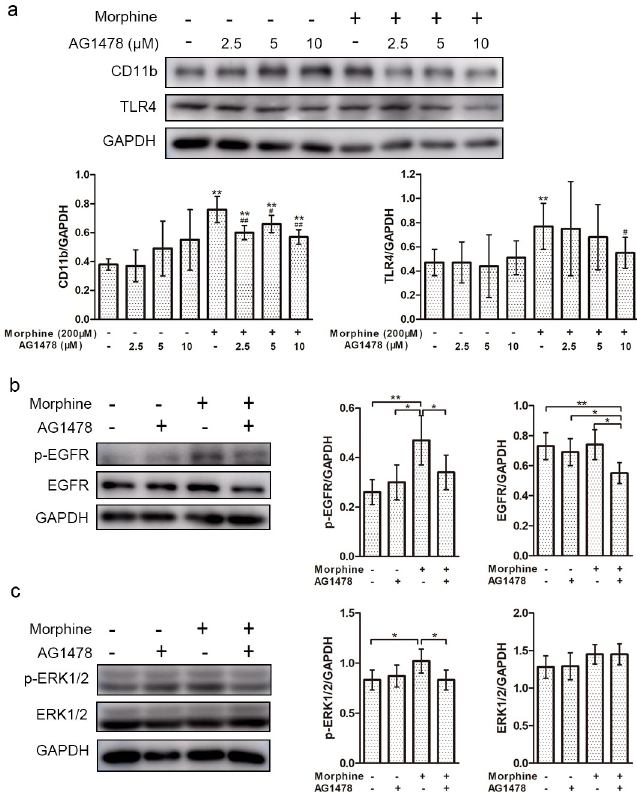
Fig 5. The effect of EGFR inhibition on morphine-induced protein expression. BV-2 cells were incubated with DMSO, AG1478 (2.5, 5, and 10 μ M), morphine (200 μ M), and AG1478 (2.5, 5, and 10 μ M) + morphine (200 μ M) for 24 h. After treatment, cell lysates were examined by Western blot for expression levels of CD11b (a), EGFR and p- EGFR (b) and ERK1/2 and p-ERK1/2 (c). GAPDH was used as a loading control. Data are expressed as the means ± SEMs. All data were analyzed using ANOVA. � p < 0.05 and �� p < 0.01 were considered to be statistically